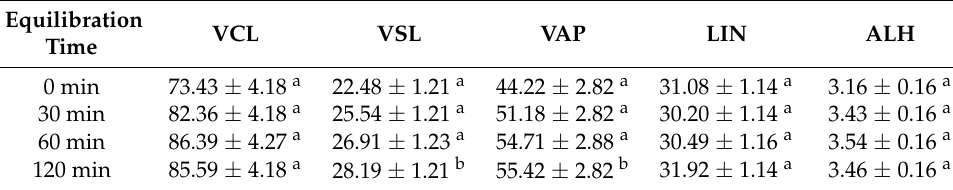
Figure 3. Effect of different equilibration times on the quality of thawed Iberian red deer epididymal spermatozoa. Sperm parameters were assessed for different equilibration times (0, 30, 60, and 120 minutes). Data represented as mean ± SEM. SM—sperm motility index (%); NAR—acrosome integrity (%); viable (nonapoptotic) spermatozoa (%); apoptotic spermatozoa (%); viable spermatozoa with active mitochondria (%); DFI—DNA fragmentation index (%). Different letters indicate significant differences between equilibration times ( p ≤ 0.05). Table 2. Effects of different equilibration times (0, 30, 60, and 120 minutes) on sperm motility CASA parameters of Iberian red deer epididymal spermatozoa. Data represented as mean ± SEM. VCL—curvilinear velocity ( µ m/seg); VSL—rectilinear velocity ( µ m/seg); VAP—velocity for the corrected trajectory ( µ m/seg); LIN—linearity (%); ALH—lateral head displacement ( µ m). Different letters within columns indicate significant differences ( p ≤ 0.05).